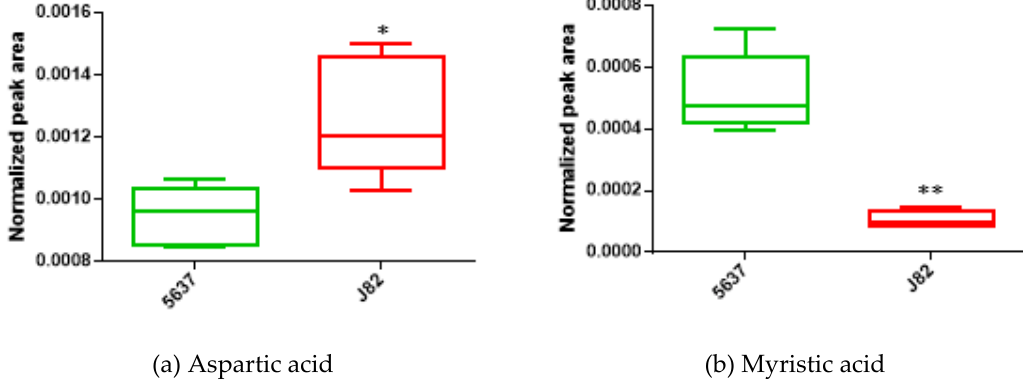
Figure 2. Boxplots of ( a ) aspartic acid and ( b ) myristic acid, two metabolites found to be significantly altered between the LG bladder cancer cell line 5637 ( n = 5) and the HG bladder cancer cell line J82 ( n = 5). * p < 0.05; ** p < 0.01.